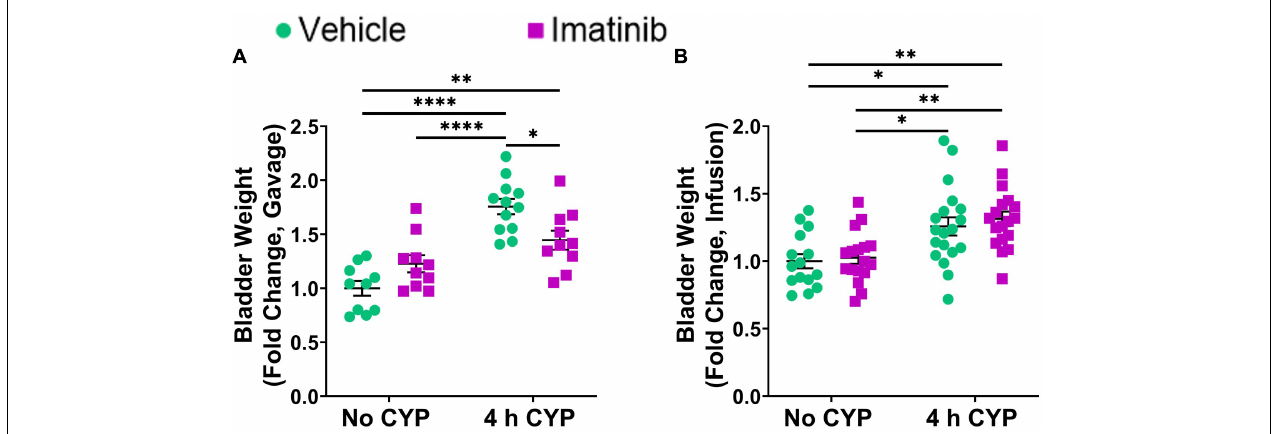
FIGURE 6 | Oral gavage of imatinib mesylate, but not transurethral bladder infusion, significantly reduces bladder weight in an acute (4 h) cyclophosphamide (CYP)-induced cystitis female mouse model. Acute (4 h) CYP treatment (200 mg/kg, i.p.) significantly (0.0001 ≤ p ≤ 0.05) increased bladder weight in (A) mice that received vehicle (water) via oral gavage for 5 days prior to CYP administration (1.8-fold) and (B) mice that received transurethral vehicle (saline) intravesical infusion 4 h post CYP administration (1.3-fold), compared to vehicle (no CYP) controls. (A) Imatinib prevention (250 mg/kg, 5 days, 1X/day) via oral gavage significantly ( p ≤ 0.05) (1.2-fold) reduced bladder weight in female mice with 4 h CYP-induced cystitis, but (B) imatinib treatment (50 µ M, 30 min) via intravesical infusion did not affect bladder weight. Raw values (g) are presented as fold change values ± SEM with respect to the control group (vehicle, no CYP). n = 10–19. * p ≤ 0.05; ** p ≤ 0.01; *** p ≤ 0.001; **** p ≤ 0.0001 by two-way ANOVA with Tukey’s multiple comparisons